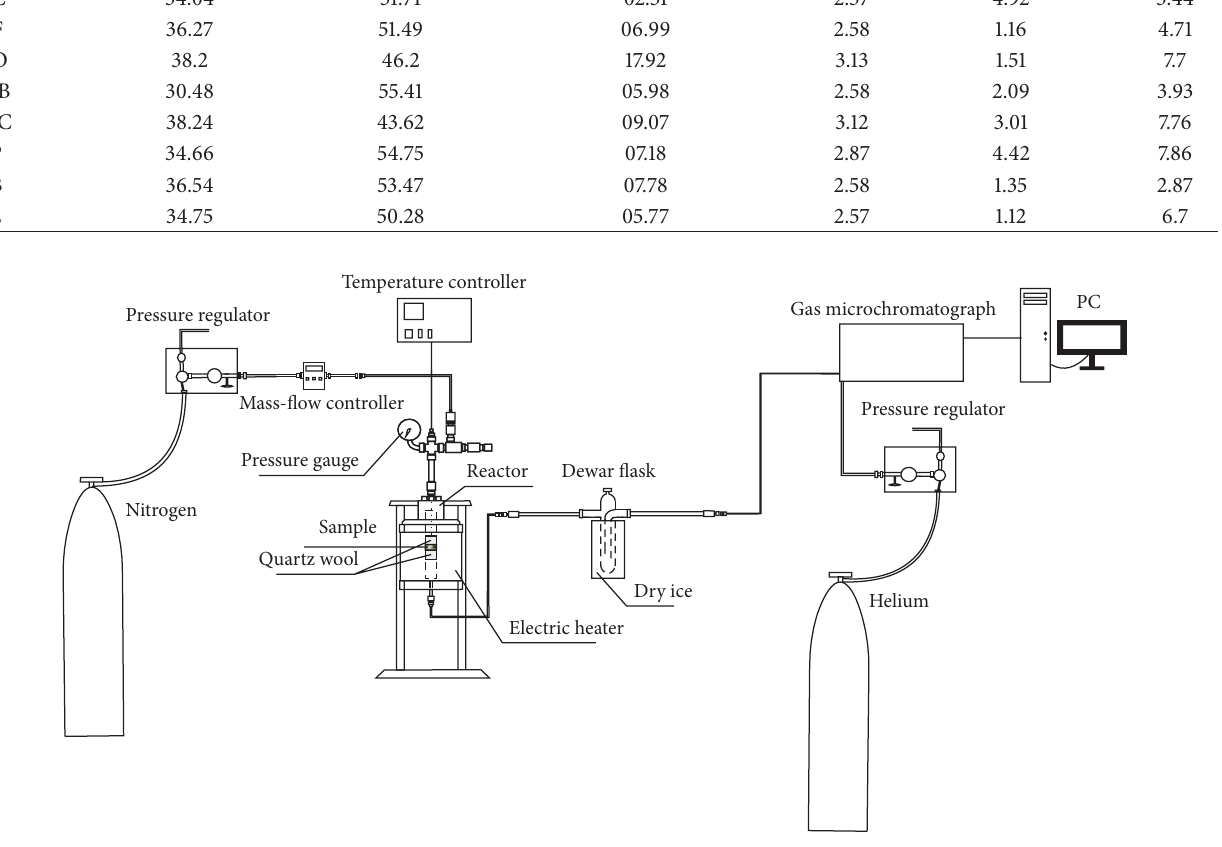
Figure 1: Experimental